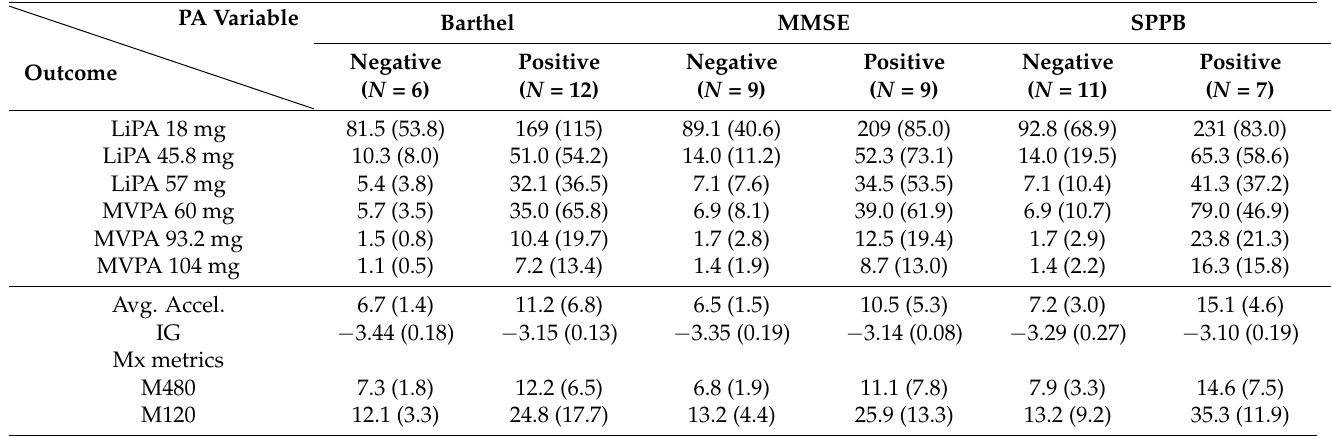
Table 5. Descriptive results of physical activity in the dichotomized groups of centenarians (median and interquartile range) for the health outcomes with statistical